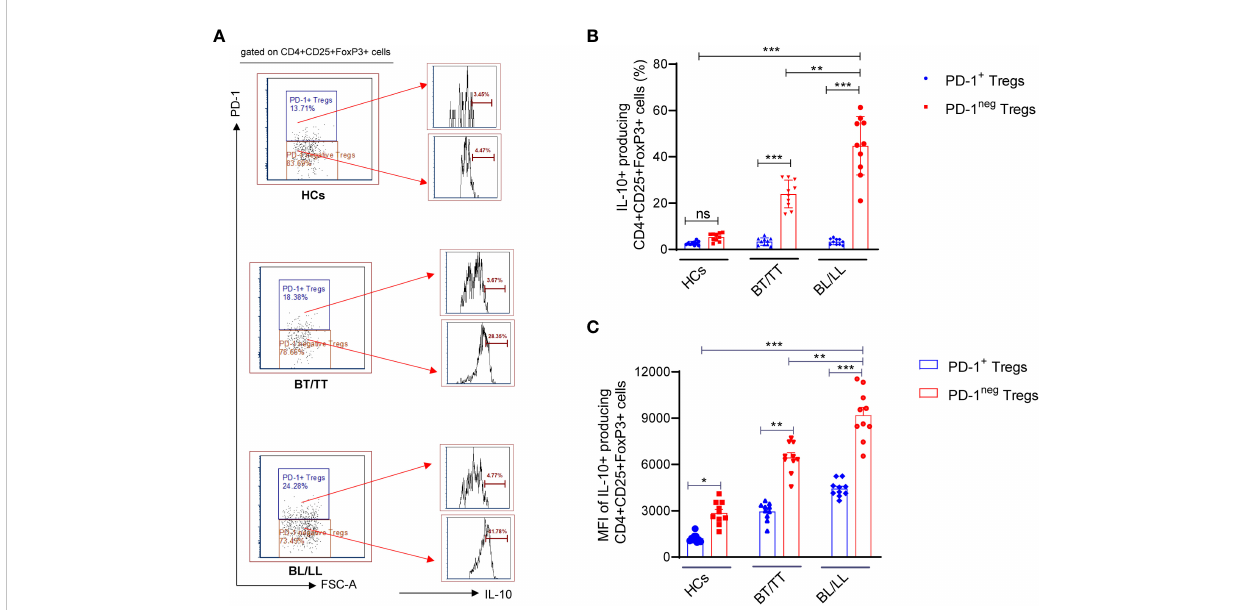
FIGURE 2 IL-10 production by PD-1 neg and PD-1+T regulatory cells in Leprosy (A) Histogram FACS cartoon showing one representative plot of each group IL- 10 production by PD-1 neg and PD-1+ Tregs as determined by FACS analysis in healthy controls (n=10), tuberculoid patients (n=10) and lepromatous leprosy patients (n=10) (B) Scattered dot plots are showing the IL-10 production by PD-1 neg and PD-1+ Tregs in different groups of Leprosy patients (BT/TT vs. BL/LL) and Healthy Contacts (n = 10) (C) Scattered dot plots are showing the mean fl uorescence intensity (MFI) of IL-10 producing by PD- 1 neg and PD-1+ Tregs in different groups of Leprosy patients (BT/TT vs. BL/LL) and Healthy Contacts (n = 10). Mean ± SD values are shown in each set while signi fi cance was determined by a P value of 0.05. A total of 100,000 cells were analyzed by fl ow cytometry. FCS express software was used for data analysis and Statistical analysis was done using one-way ANOVA for unpaired samples (*p < 0.05; **p < 0.005; ***p <